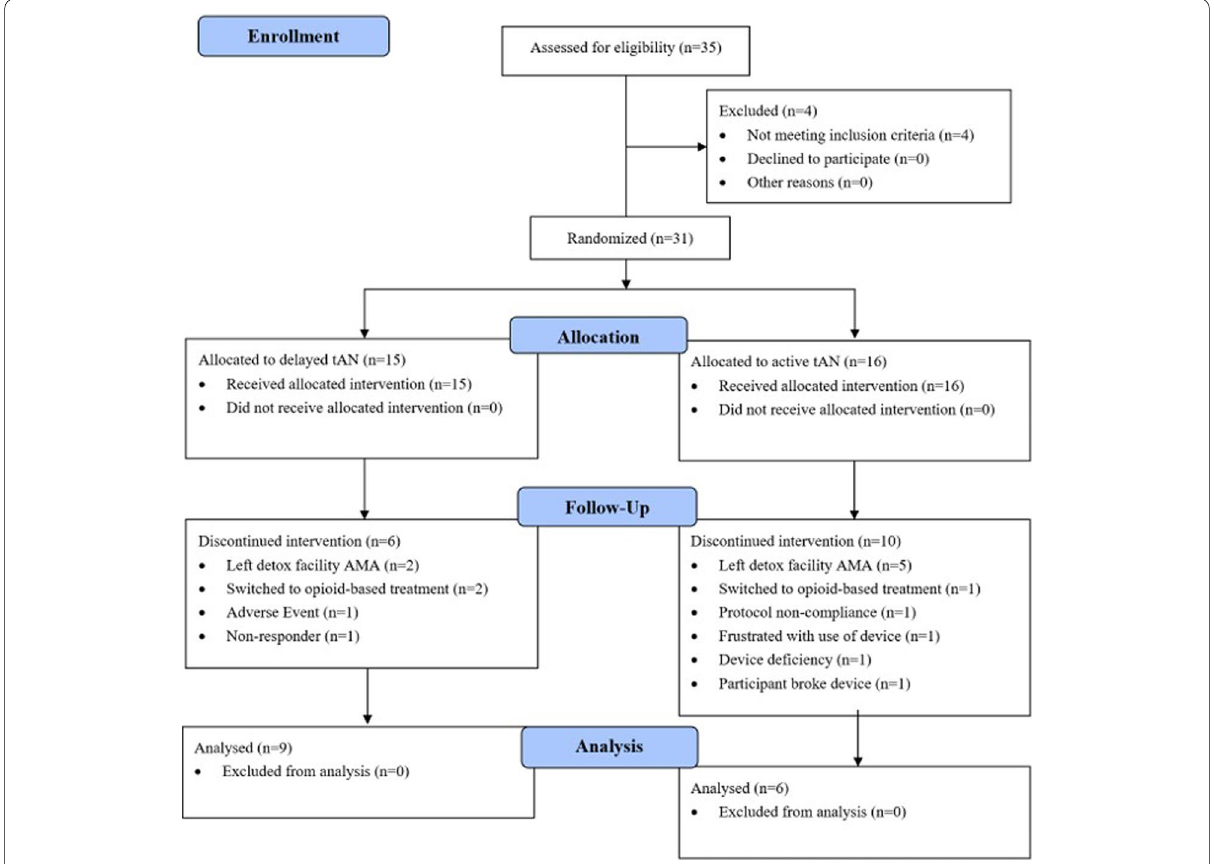
Fig. 3 CONSORT Flow